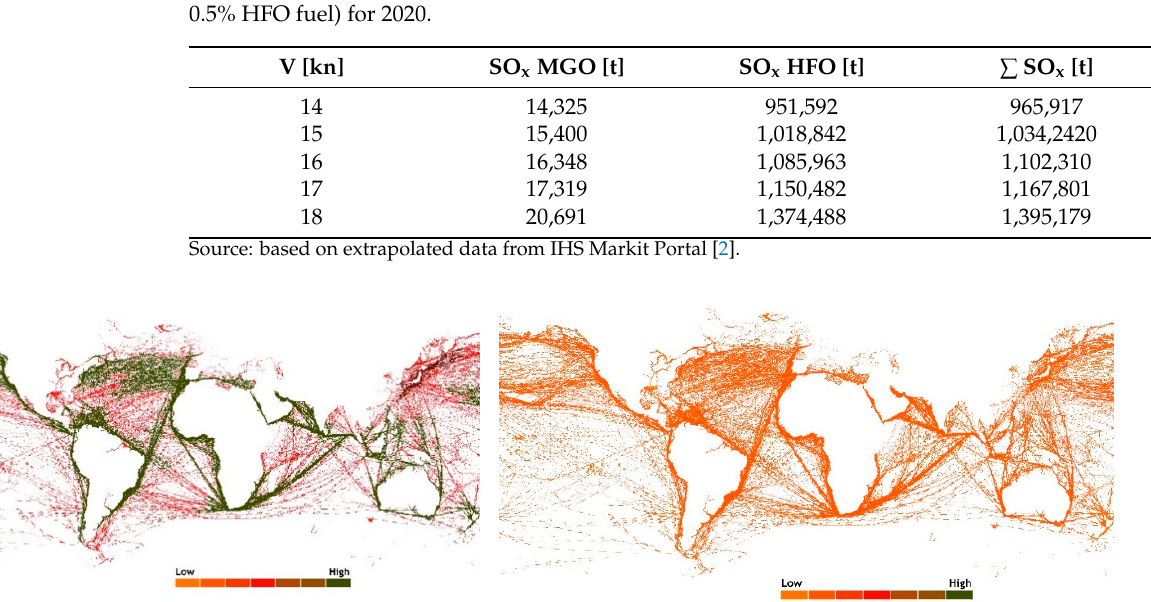
Table 7. Estimated amount of SO x emissivity in container shipping under global cap conditions (i.e.,